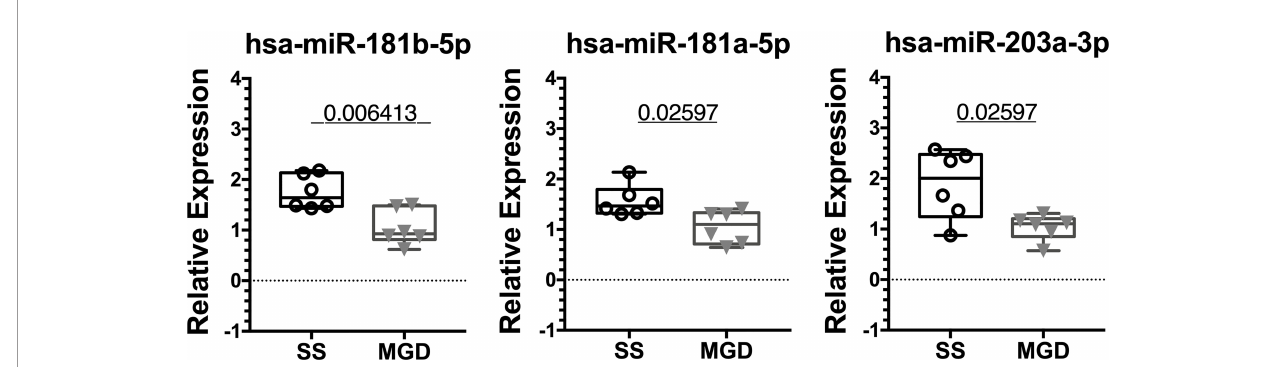
FIGURE 7 | qRT-PCR validation of miRNA hits in human tears from patients with SS or MGD. In a small cohort of patients, miRNAs hsa-miR-181a-5p, hsa-miR- 181b-5p and hsa-miR-203a-3p were signi fi cantly upregulated in tears of SS patients when compared to tears of patients with MGD. Data were fi rst normalized for variation arising from RT and PCR using spiked-in control. Statistics were performed on D Ct values normalized to hsa-miR-25-3p. Mean DD Ct values are plotted as boxplots showing the mean with 75% to 25% IQR and whiskers depicting the range. (N=6 samples each for SS and MGD patients; unpaired t-test with equal variances assumed; p=0.05).